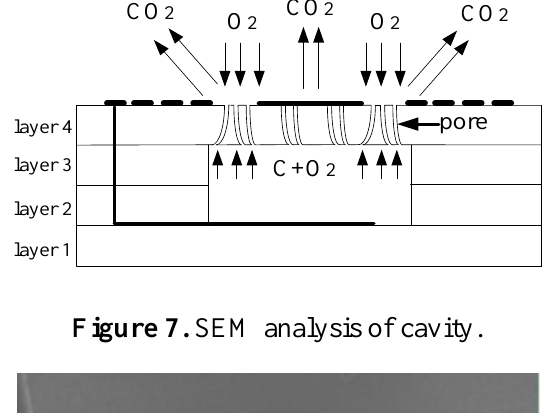
Figure 7. SEM analysis of